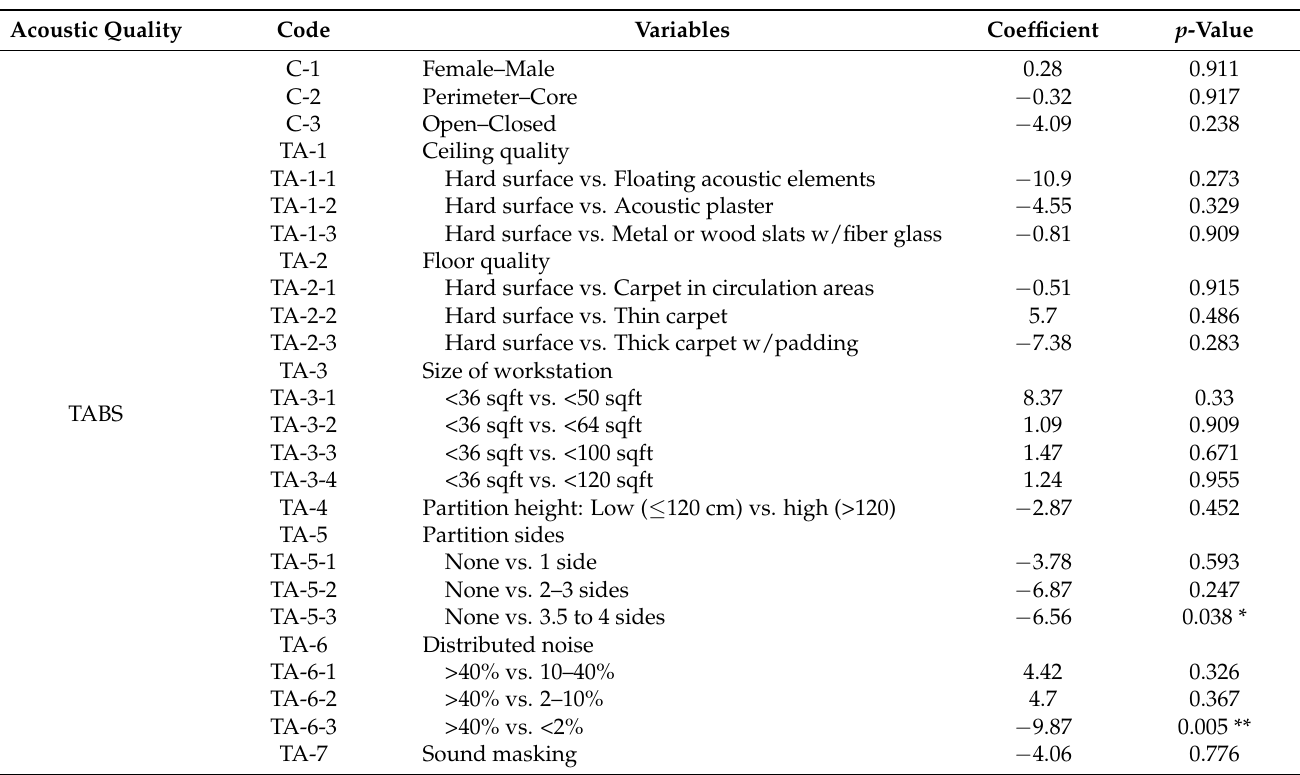
Table 9. Correlation analysis between TABS and Noise Criteria ( n = 498).